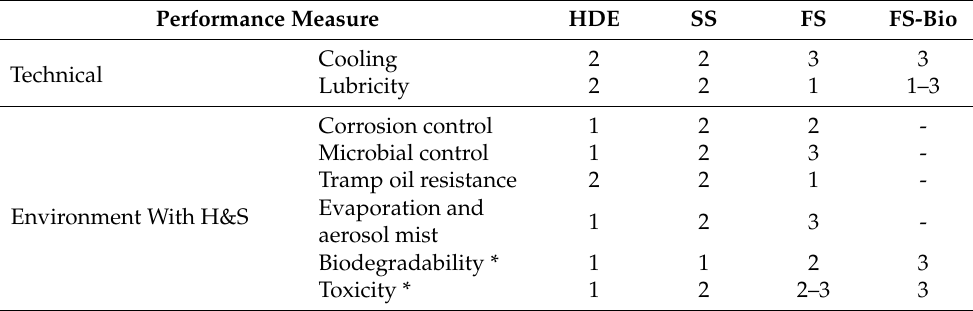
Table 2. Relative ranking of each CF group with Excellent = 3, Good = 2 and Baseline = 1. Performance Measure HDE SS FS FS-Bio Cooling 2 2 3 3 Technical Lubricity 2 2 1 1–3 Corrosion control 1 2 2 - Microbial control 1 2 3 - Tramp oil resistance 2 2 1 - Evaporation and Environment With H&S 1 2 3 - aerosol mist Biodegradability * 1 1 2 3 Toxicity * 1 2 2–3